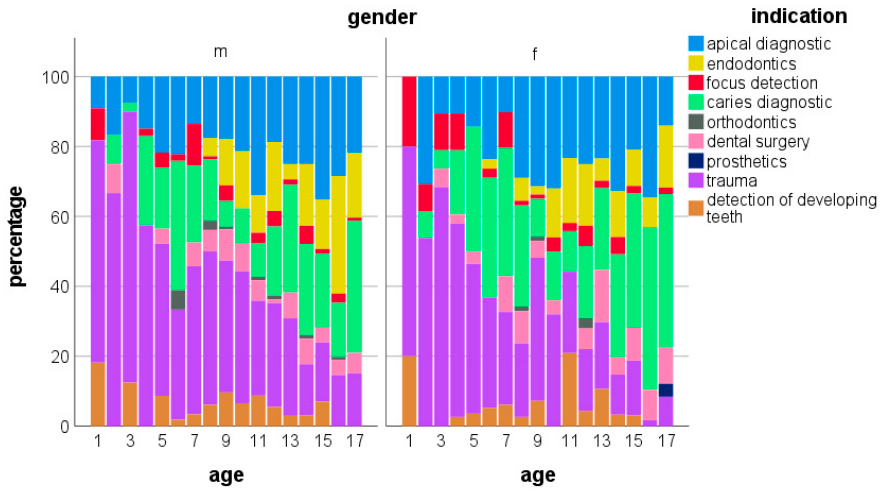
Figure 4. Age-related gender distribution of indications for intraoral radiographs.